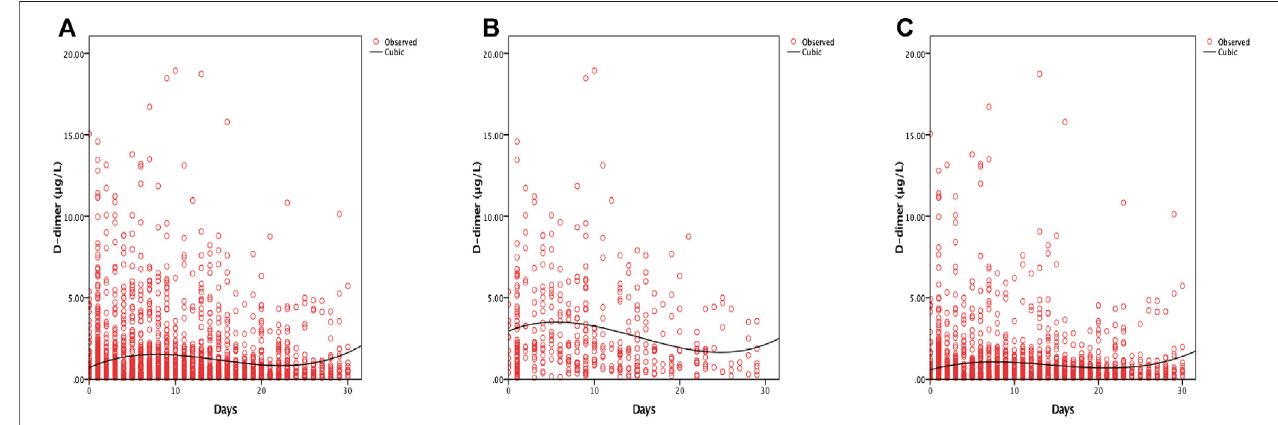
FIGURE 2 | Curve fi tting analysis for all the COVID-19 patients (A) , anticoagulant group (B) and non-anticoagulant group (C) .